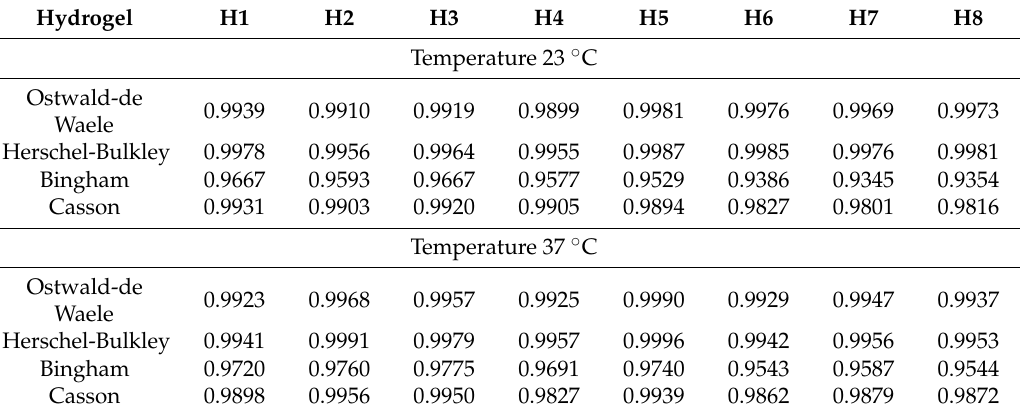
Table 1. Determination coefficients (”R 2 ”) values specific to different rheological models obtained in relation with forward rheograms for hydrogels tested at 23 ˝ C and 37 ˝ C.